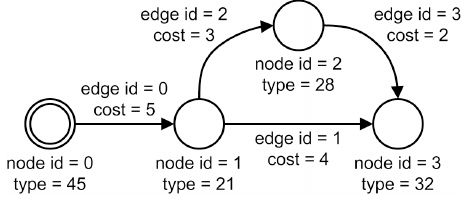
Fig. 2. TG XML structure